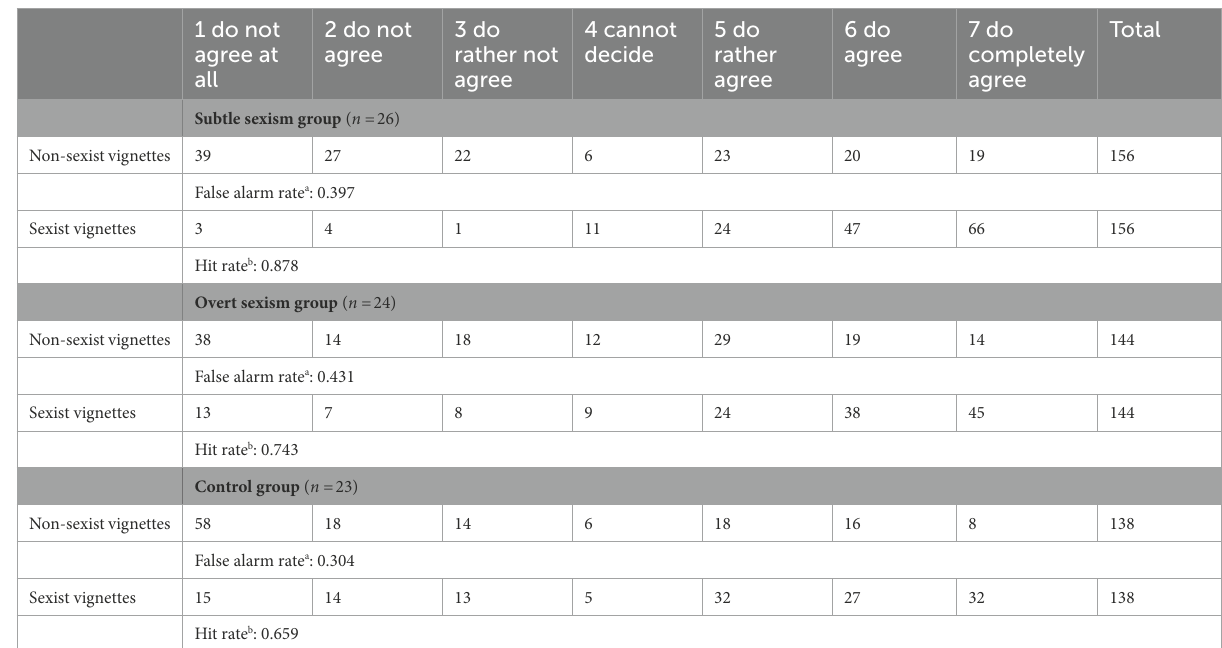
TABLE 1 Frequencies of responses to the statement: this statement is sexist.